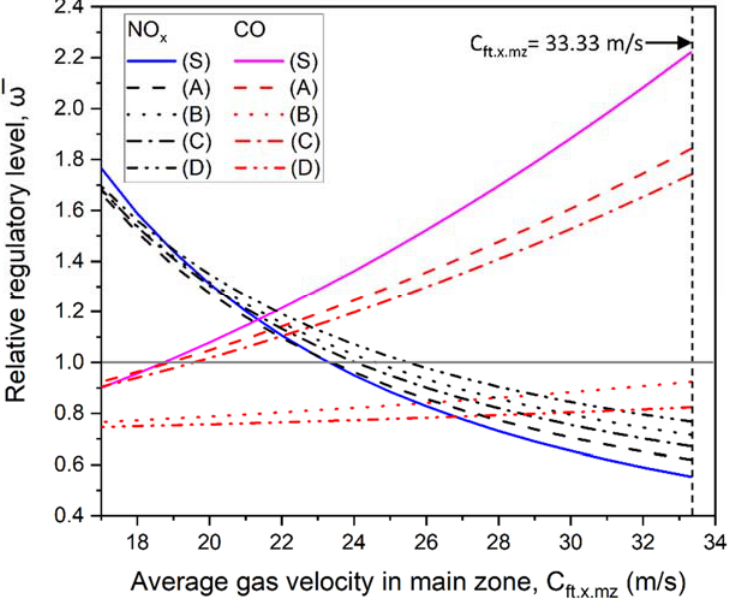
Figure 11. Relationship of regulation level for NOx and CO with gas velocity in the main zone.